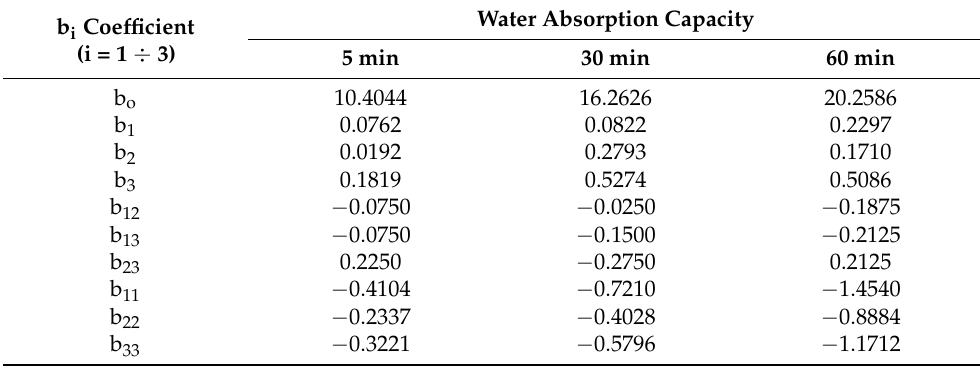
Table 4. The coefficients of mathematical equations obtained with multiple linear regression (MLR) for water absorption capacity after 5 to 60 min.